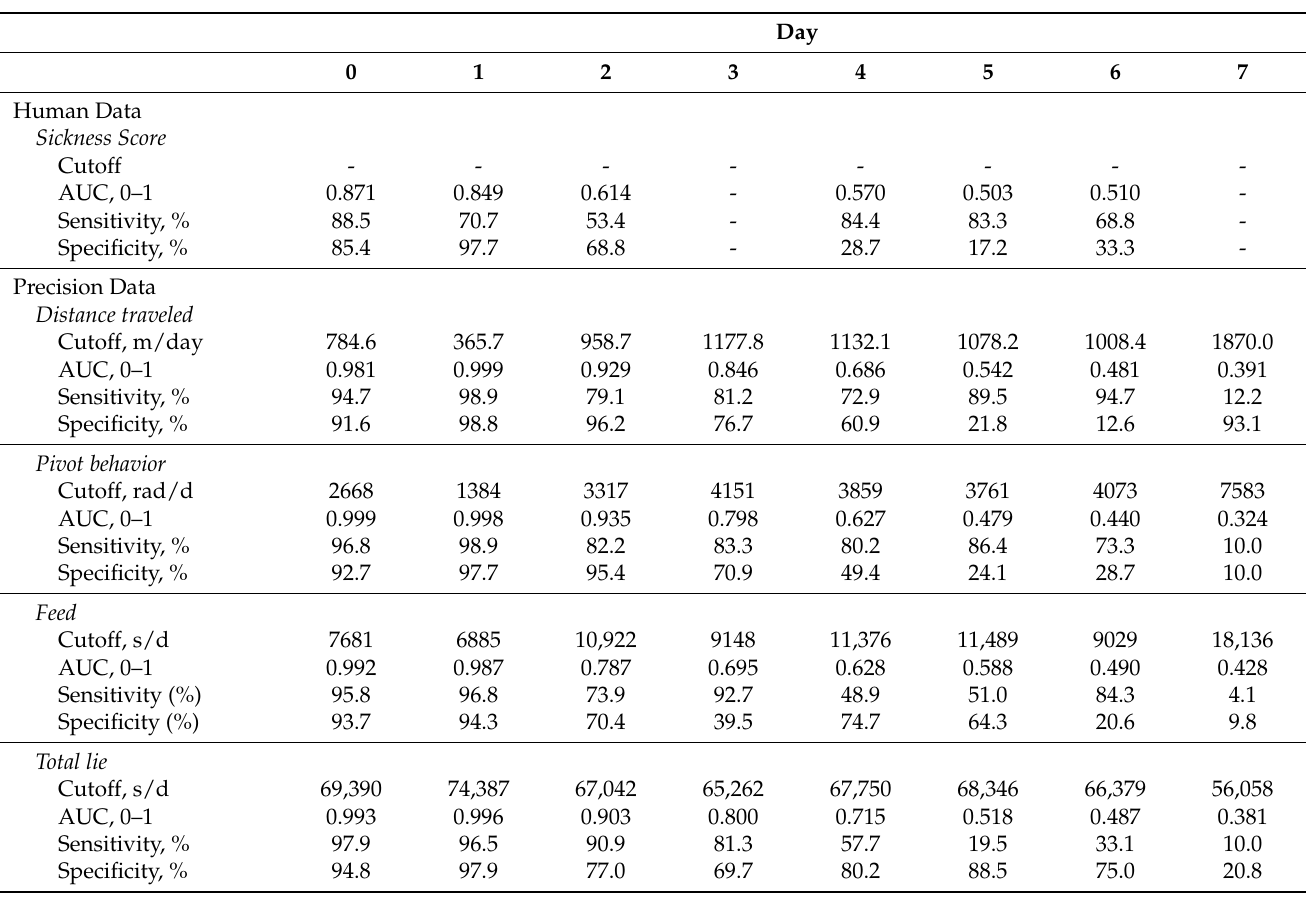
Table 1. The entire population of nursery pig optimal cutoff values, the area under the curve (AUC), sensitivity, and specificity for human data and precision data (NU track ). Pigs received treatments randomly assigned by pen: (1) pens with all sham-handled, control pigs (injection of 3 mL saline solution); (2) pens with all challenged-pigs (subcutaneous dose of lipopolysaccharide (LPS